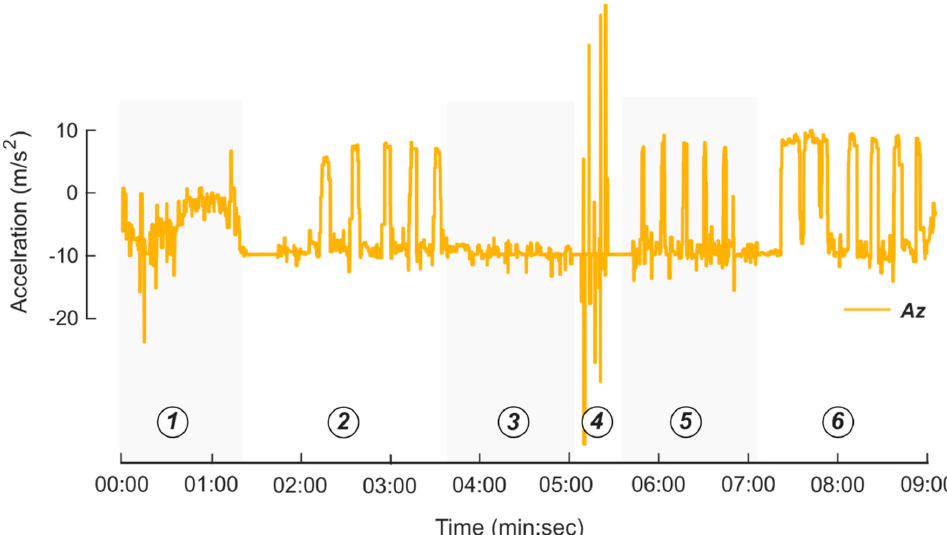
Figure 4. Example Institutional Review Board (IRB) trial data for z -axis accelerometer from one